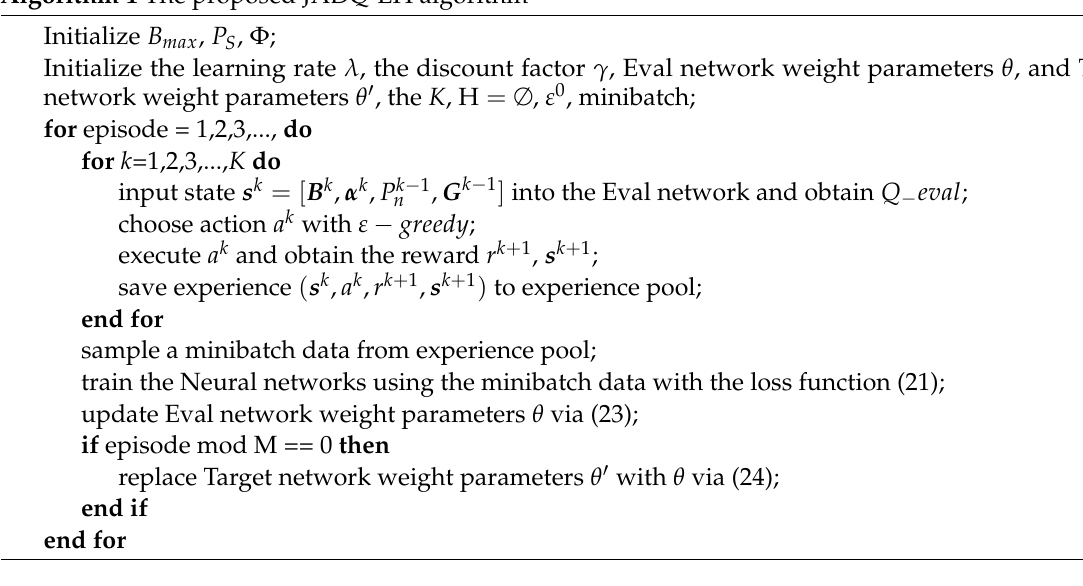
Algorithm 1 The proposed JADQ-EH